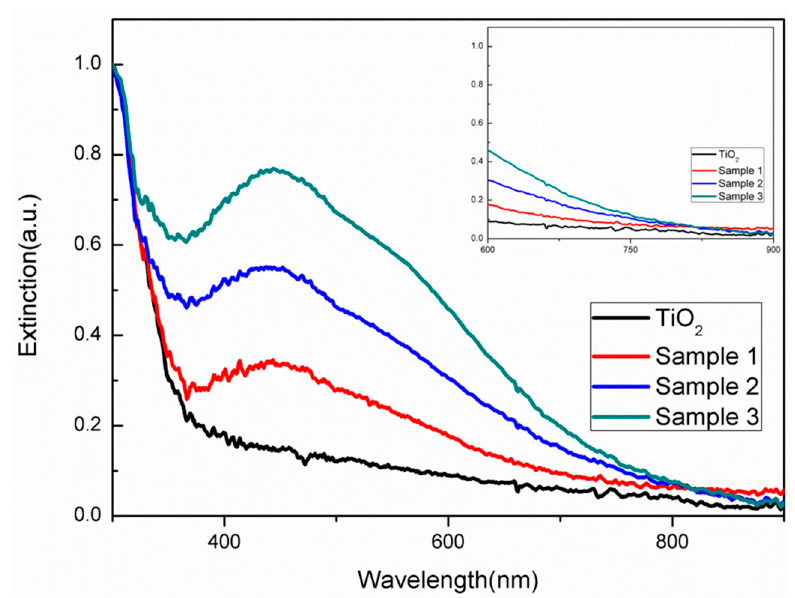
Figure 3. Extinction spectrum of pure TiO 2 nanorods and Ag-TiO 2 nanorod composites under the different times of illumination (Sample 1–3 with 60, 180, and 300 min of UV radiation). Inset shows the edges of TiO 2 and Sample 1 to